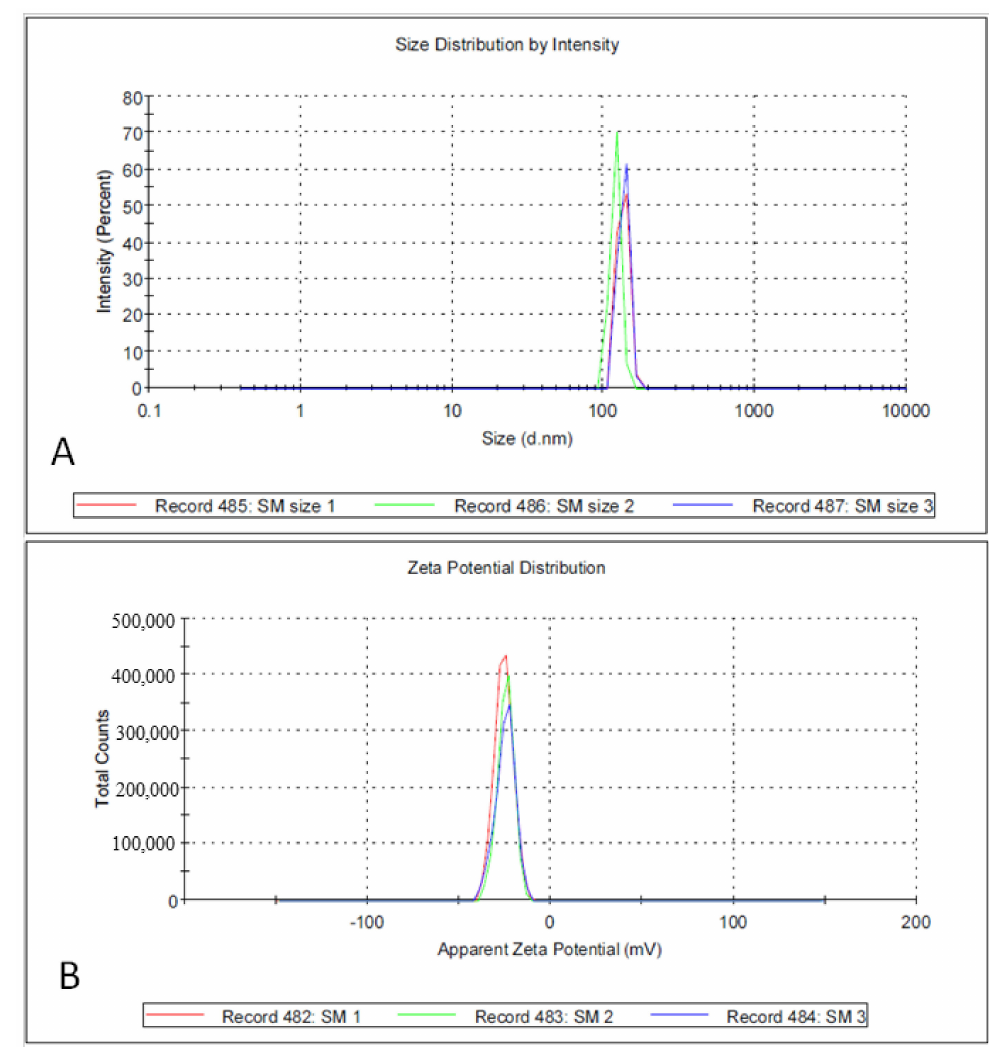
Figure 4. Size distribution analysis of biosynthesized SMAgNPS by dynamic light scattering (DLS) observed as 135.8 nm ( A ). Zeta potential was recorded as − 24.9 mV ( B